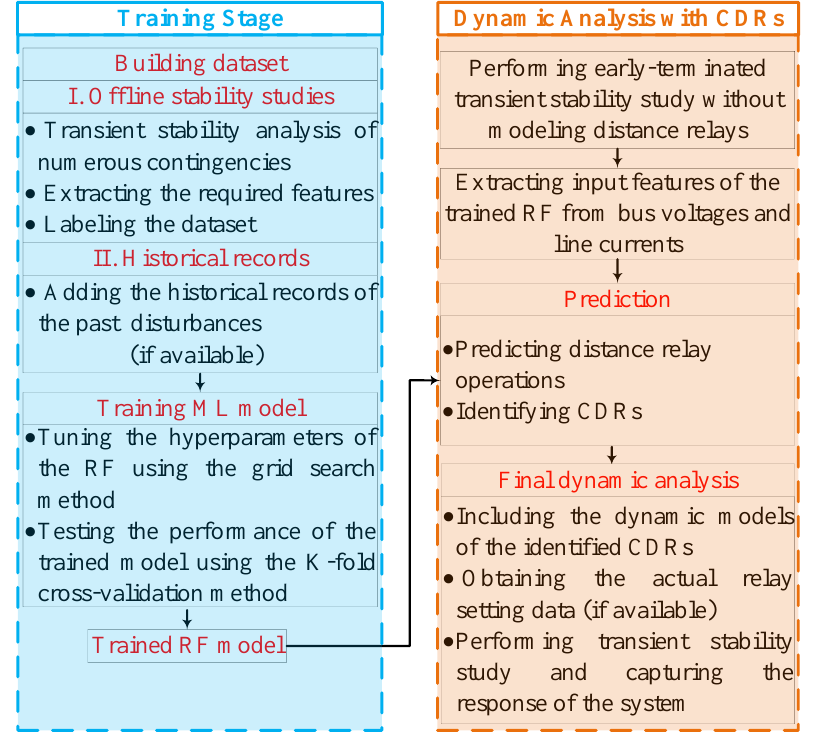
Figure 1. The flowchart of the proposed method.